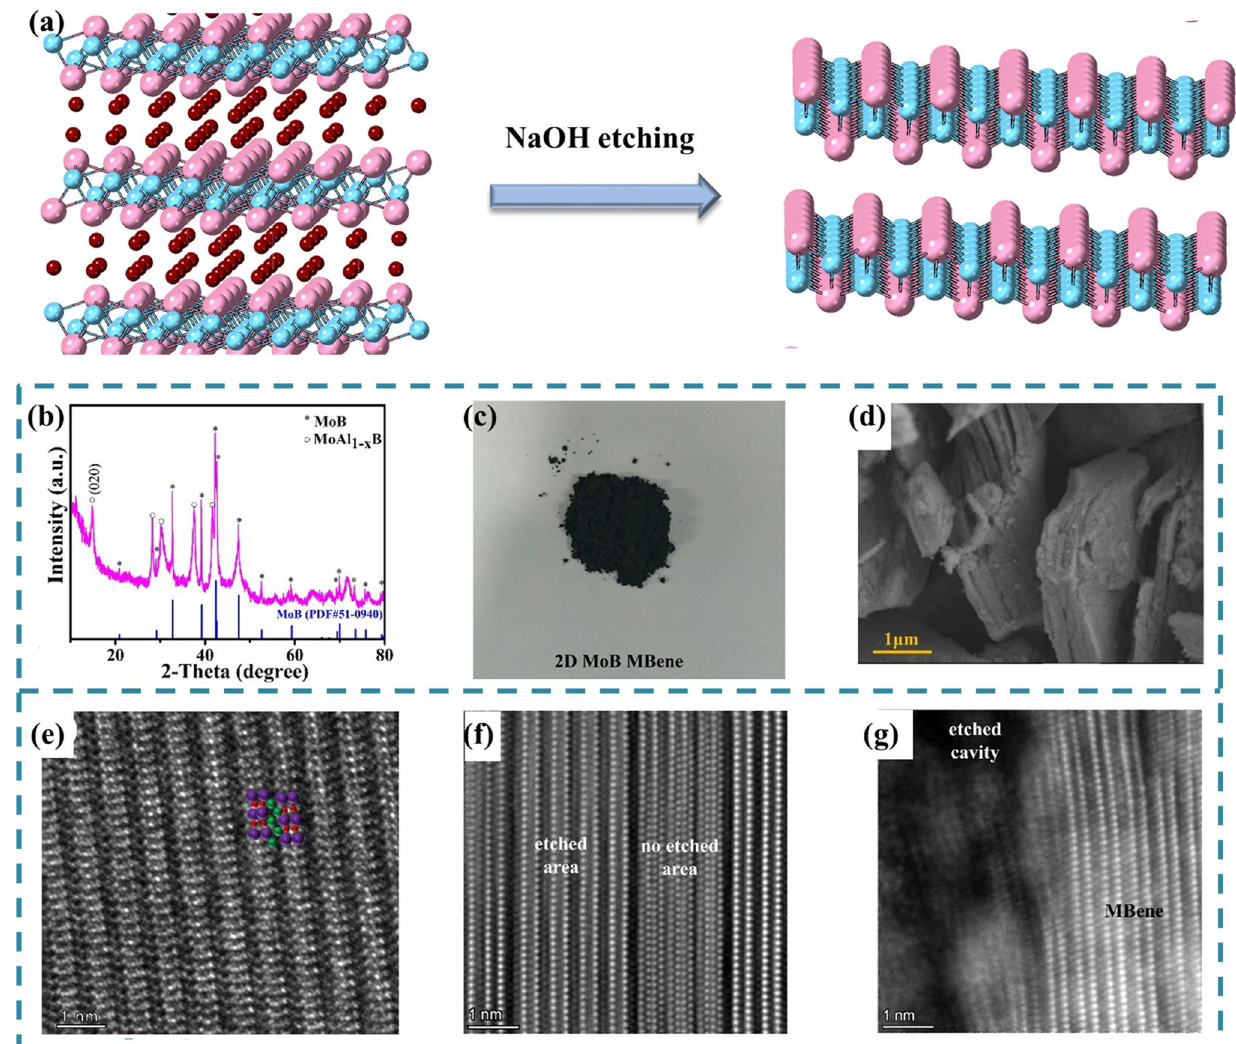
Fig. 7 a Schematic of the synthesis of 2D MoB MBene from MoAlB phases. b XRD patterns of 2D MoB MBene. c Optical images of 2D MoB MBene powders. d SEM images of 2D MoB MBene. Atomic scale resolution ADF-STEM image of e MoAlB, f, g 2D MoB